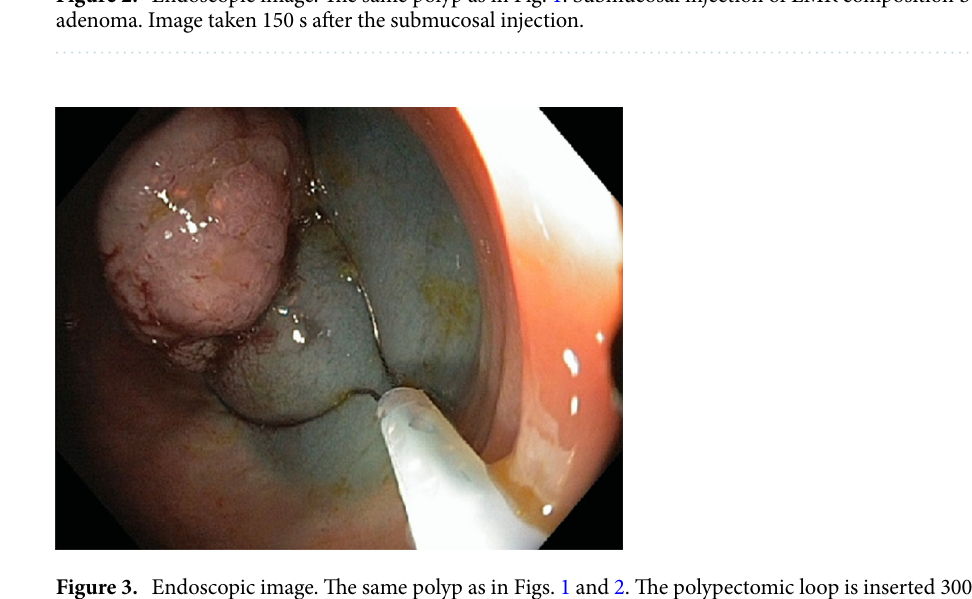
Figure 3. Endoscopic image. The same polyp as in Figs. 1 and 2. The polypectomic loop is inserted 300 s after the submucosal injection of EMR composition.